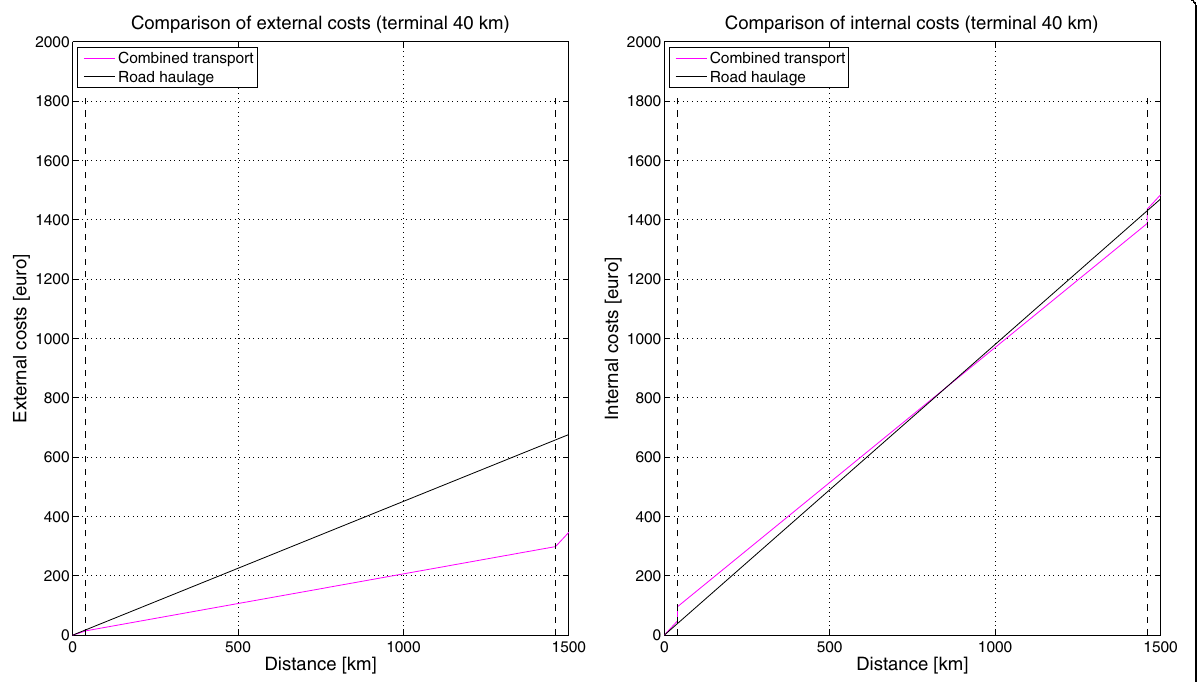
Fig. 18 Comparison of the external and internal costs for the two alternatives using an electric solution for drayage (terminal location: 40 km) (related to the transport of one standard ITU 40 ′